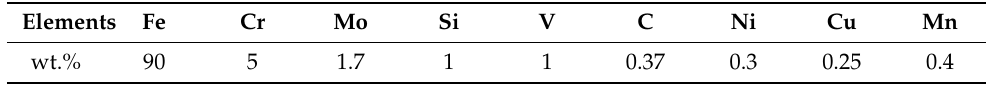
Table 3. Chemical composition of the tool material—H13 Tool